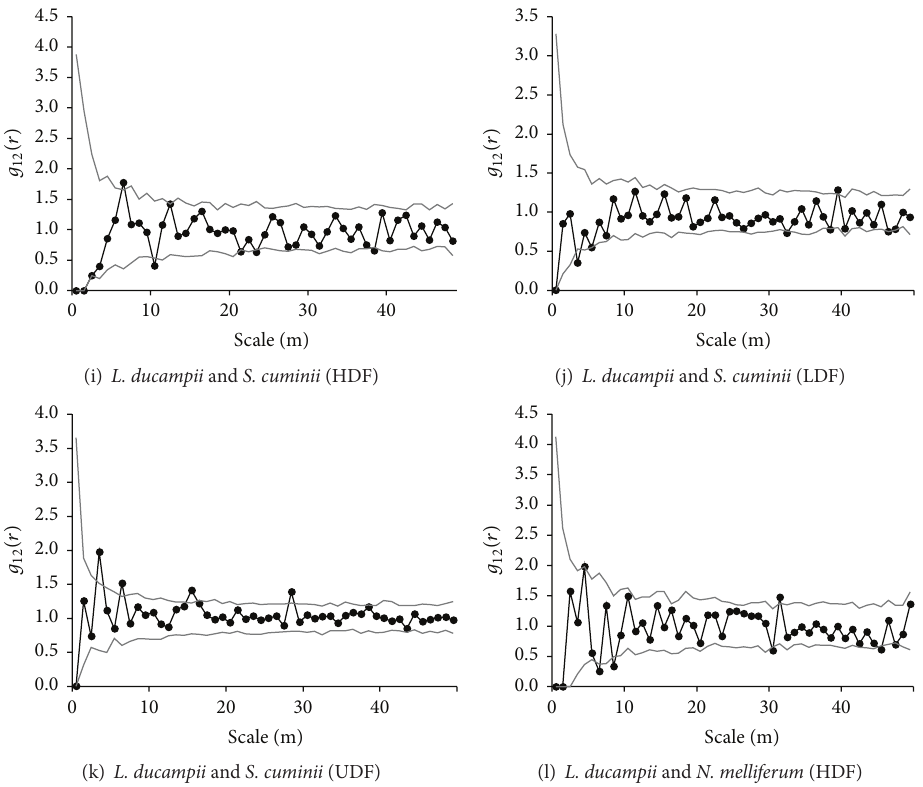
Figure 8: Spatial correlations among the five most abundant tree species are shown by the bivariate pair-correlation. The observed patterns (dark line) that lie beyond the confidence envelopes (grey lines) indicate significant departures from the null models of toroidal shift (spatial